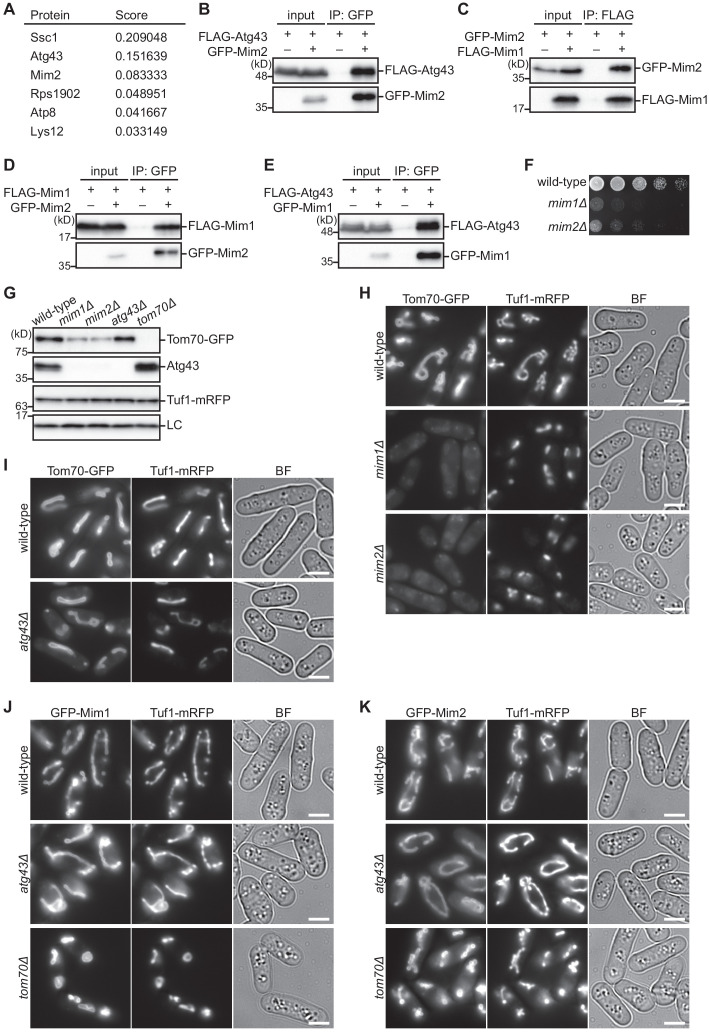
The MIM complex facilitates the mitochondrial localization of Atg43 and Tom70.(A) Identification of Mim2 as an Atg43-binding protein. Mass spectrometric analysis of proteins co-purified with the 80 C-terminal aa of Atg43 with a FLAG tag was conducted. Wild-type cells expressing untagged Atg43 were used as a negative control. The value (score) represents the relative protein abundance as expressed by spectral abundance factor (SAF). Mim2 was identified along with 37 peptide-spectrum matches, at a targeted false discovery rate (FDR) of 1.0% at the peptide level. (B–E) Atg43 interacts with the MIM complex. Immunoprecipitation experiments were conducted using crude cell lysates (input) prepared from cells with (+) or without (–) expression of the indicated proteins. Anti-FLAG (IP: FLAG) and anti-GFP (IP: GFP) immunoprecipitants were analyzed by immunoblotting. (F) The indicated strains were grown in EMM, and their serial dilutions were spotted onto solid YES medium for the growth assay. (G) Atg43 is unstable in the absence of the MIM complex. The indicated strains co-expressing Tom70-GFP and Tuf1-mRFP were grown in EMM for immunoblotting. Histone H3 was used as a loading control (LC). (H, I) Mitochondrial localization of Tom70 requires the MIM complex but does not require Atg43. The indicated strains co-expressing GFP-tagged Tom70 with Tuf1-mRFP were grown in EMM for microscopy. (J, K) Mitochondrial localization of the MIM complex is independent of Atg43 and Tom70. The indicated strains co-expressing Tuf1-mRFP with GFP-tagged Mim1 (J) or Mim2 (K) were grown in EMM for microscopy. Scale bars denote 5 µm. BF, bright-field image.